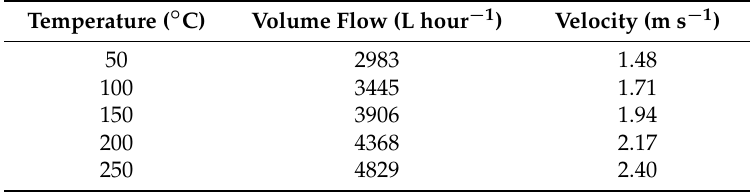
. ( V ) and velocity v at different flow Table 2. Volume flow